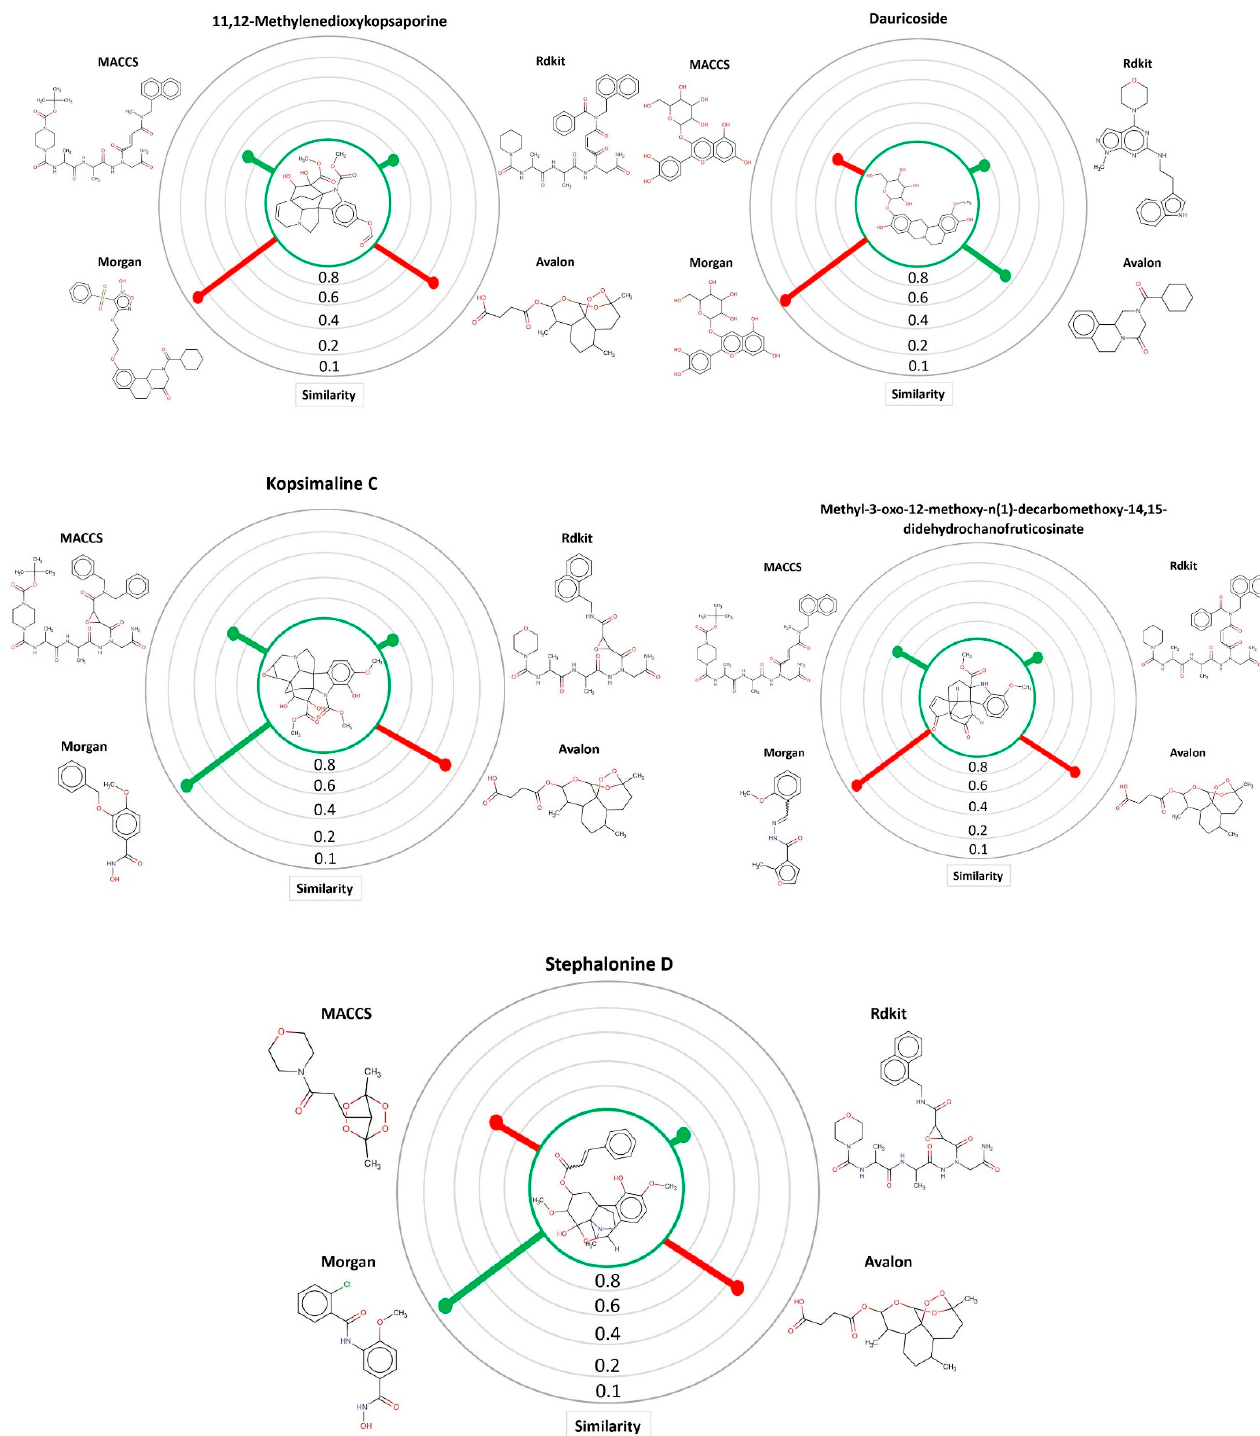
Figure 4. MuDRA plots for five consensus hits. Green—similarity to active compounds against S. mansoni and red—similarity to inactive compounds against S. mansoni .